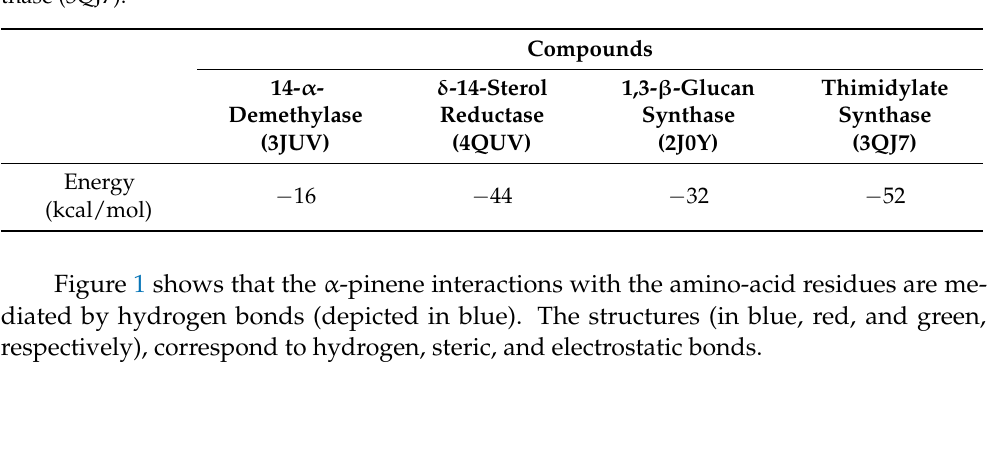
Table 1. Binding-energy (kcal mol − 1 ) values of α -pinene with the molecular targets 1,3- β -glucan synthase (2JOY), δ -14-sterol reductase (4QUV), 14- α -demethylase (3JUV), and thymidylate syn- thase